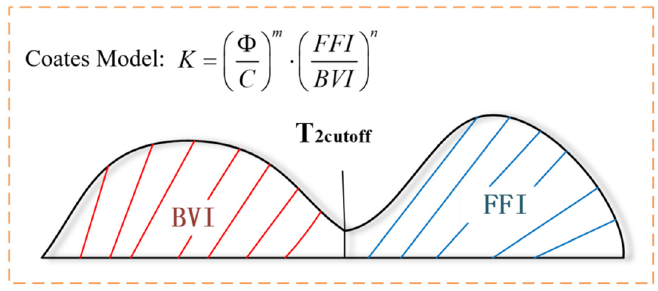
Figure 4. Coates model mechanism diagram.